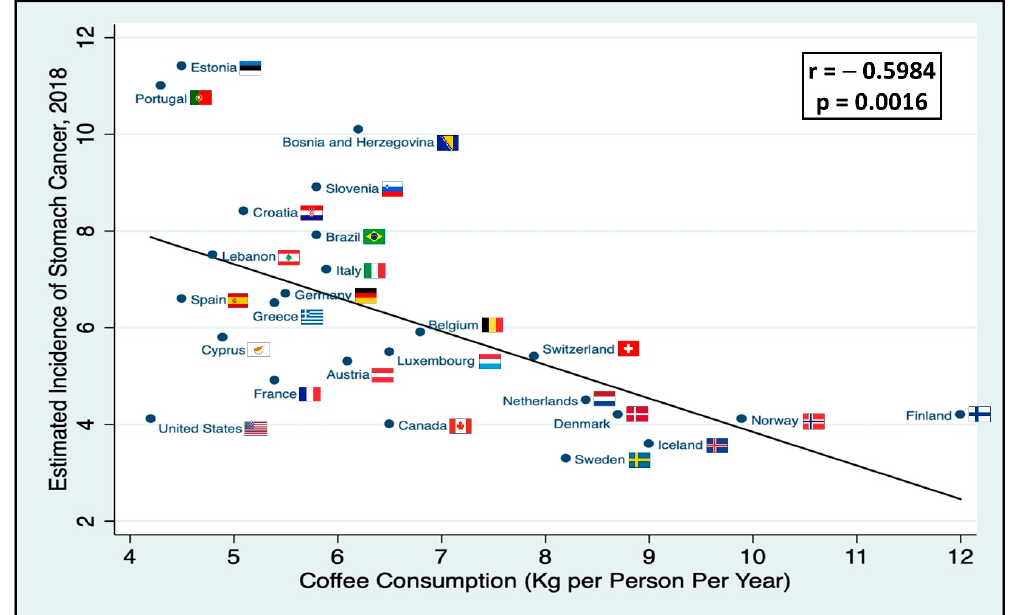
Figure 1. Coffee consumption and stomach cancer incidence. It shows the per country correlation between annual coffee consumption and the estimated age-standardized incidence of stomach cancer in 2018. Lineal model for incidence; incidence of stomach cancer = 10.79–0.69 * (coffee consumption).